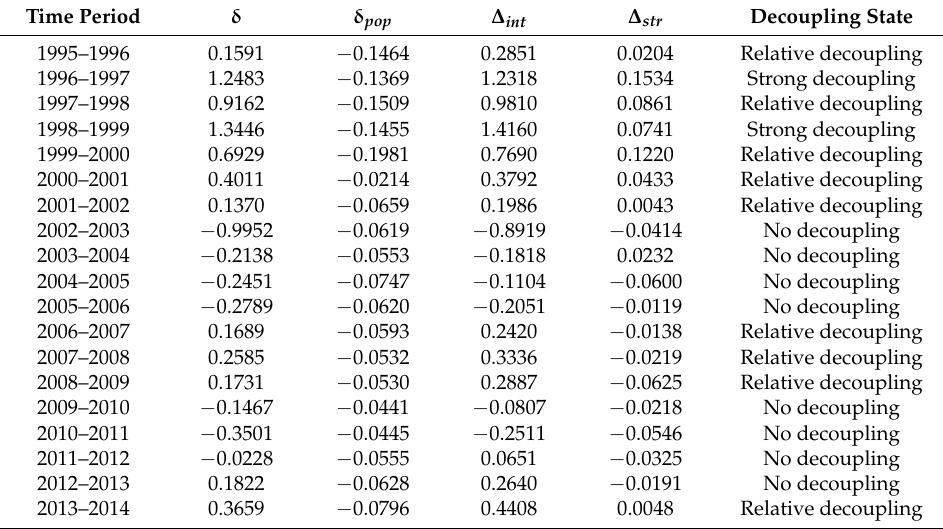
Table 4. Decoupling of CO 2 emissions and economic